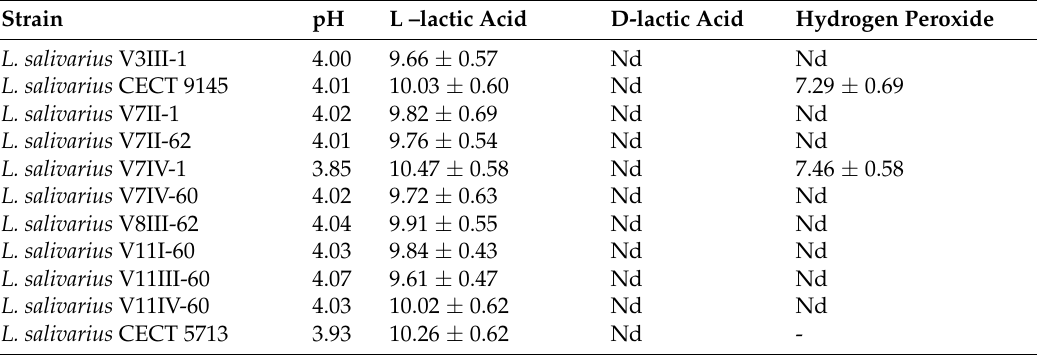
Table 1. The pH and concentrations of L- and D-lactic acid (mg/mL; mean ± SD), and hydrogen peroxide ( µ g/mL; mean ± SD) in the supernatants obtained from the MRS cultures of the lactobacilli ( n = 4). pH L –lactic Acid D-lactic